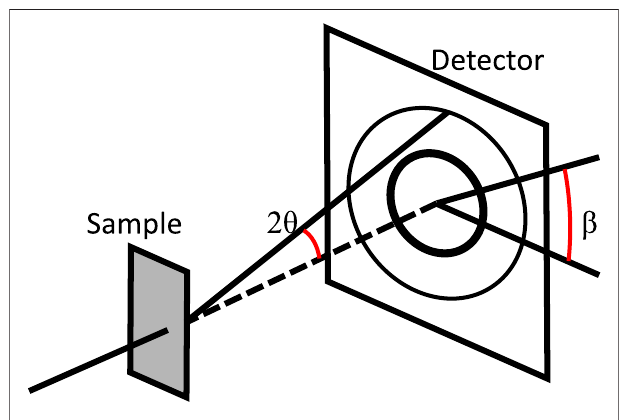
FIGURE 2 | An illustrative sketch of the in situ HEXRD set up at the 11- ID-C beamline of the Advanced Photon Source at Argonne National Laboratory. Adapted from Mueller et al. (2021). Elsevier © 2021.